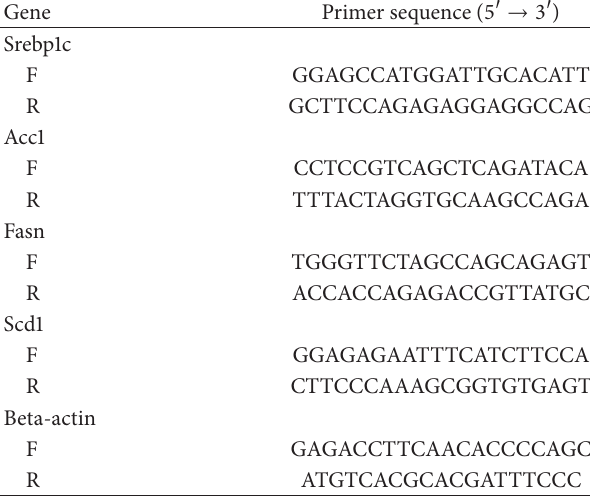
Table 1: Primer sequences for SYBR Green probes of target